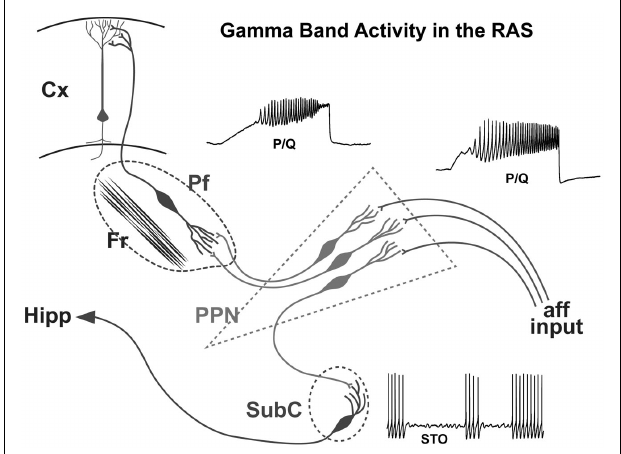
FIGURE 5 |Wiring diagram and mechanisms behind gamma band activity in the RAS. Afferent input that originates from collateral activation of the RAS by sensory systems activates the dendrites of PPN neurons. The presence of inputs to dendritic P/Q- and N-type calcium channels set off oscillations at gamma band that influence firing frequency.The output of the PPN descends to the Subcoeruleus (SubC), presumably activating these neurons that have sodium-dependent subthreshold oscillations.These cells in turn influence downstream systems involved in the atonia of REM sleep, and ascending systems that may participate in the consolidation of memories such as the hippocampus (Hipp).The output of the PPN also ascends to the intralaminar thalamus, especially the parafascicular nucleus (Pf), activating its dendrites to oscillate at gamma frequency via P/Q- and N-type calcium channels.These cells in turn project to the cortex, particularly to upper cortical layers where the non-specific thalamic inputs terminate, to activate cortical neurons. Once cortical, hippocampal, and cerebellar cells are activated, the generation and maintenance of gamma band activity in the brain can more easily be